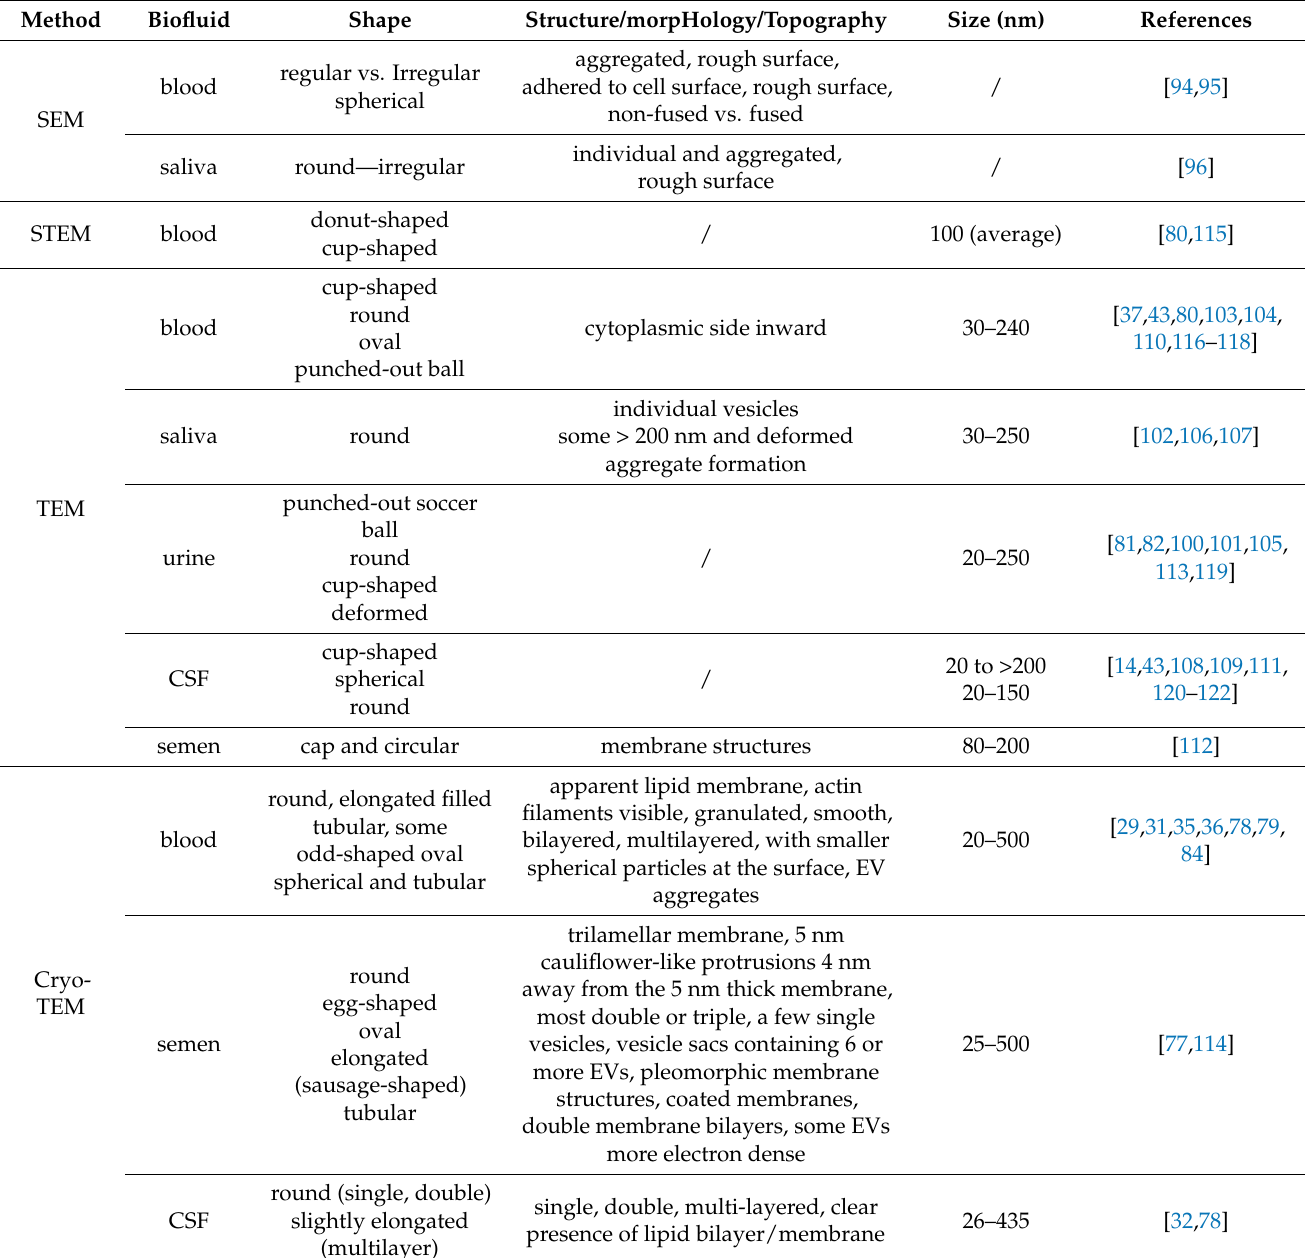
Table 1. Morphological and structural characteristics of the EVs from the human biofluids as obtained by electron microscopy. Method Biofluid Shape Structure/morpHology/Topography Size